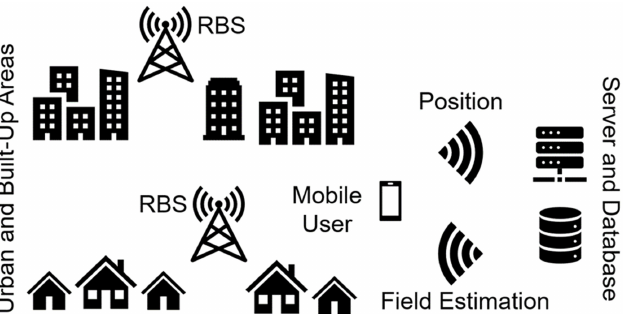
Figure 3. General scheme for the Onde Chiare system. The user can access the database, using an Android device, to check geolocalized information in order to recover the set of surrounding RBSs. The server elaborates the electric field estimation using the modified version of the C231WI model with the geographical and topological data and then sends the output to the user.